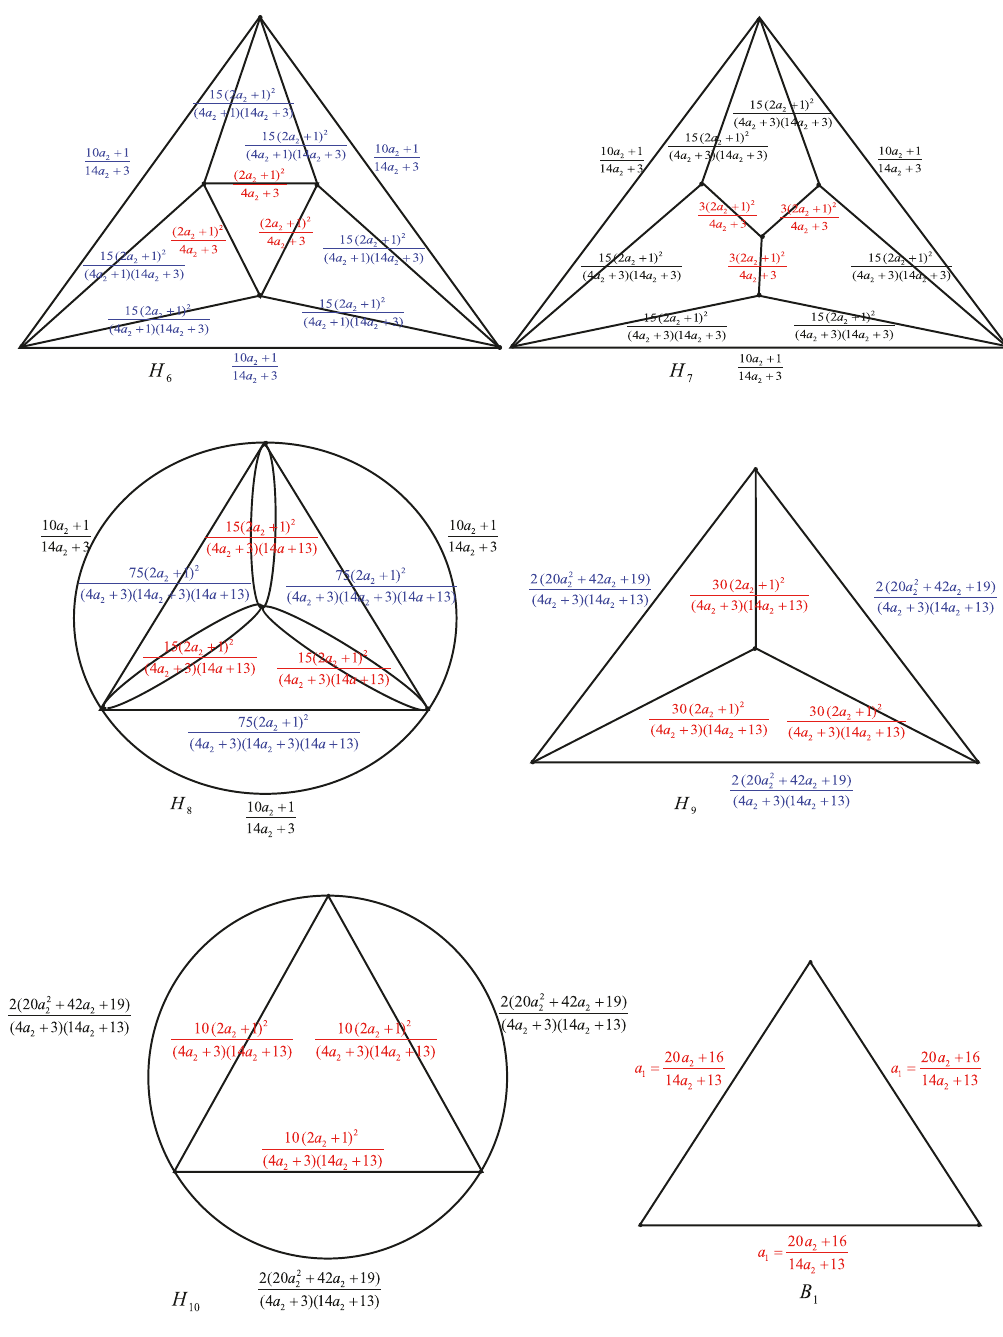
Figure 6: The transformations from 𝐵 2 to 𝐵 1